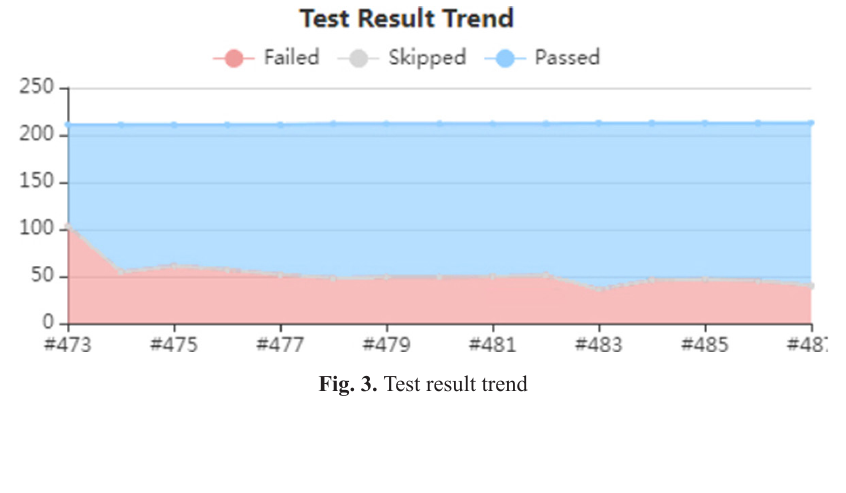
Fig. 3. Test result